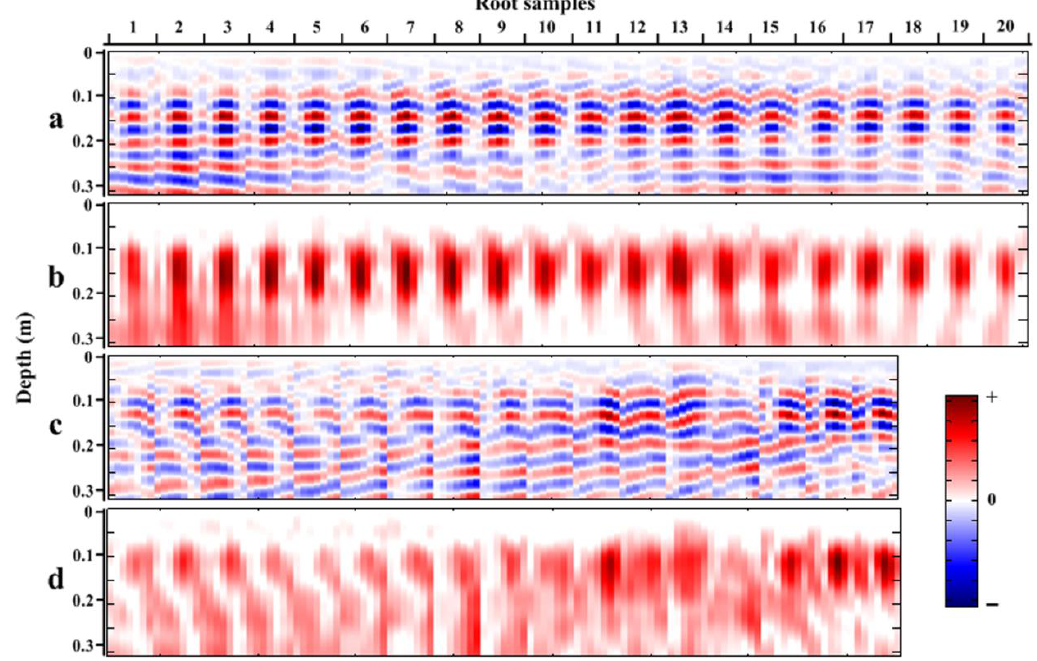
Figure 7. Spliced GPR profiles of root 1 and 2 samples extracted along Y direction from the migrated data cube. The serial number of abscissa represents each root sample which has a same width of 7 pixels (16.8 cm). ( a ) Amplitude profile of 20 samples all extracted from root 1; ( b ) Magnitude profile of the samples from root 1 after Hilbert transform; ( c ) Amplitude profile of 17 samples all extracted from root 2; ( d ) Magnitude profile of the samples from root 2 after Hilbert transform.